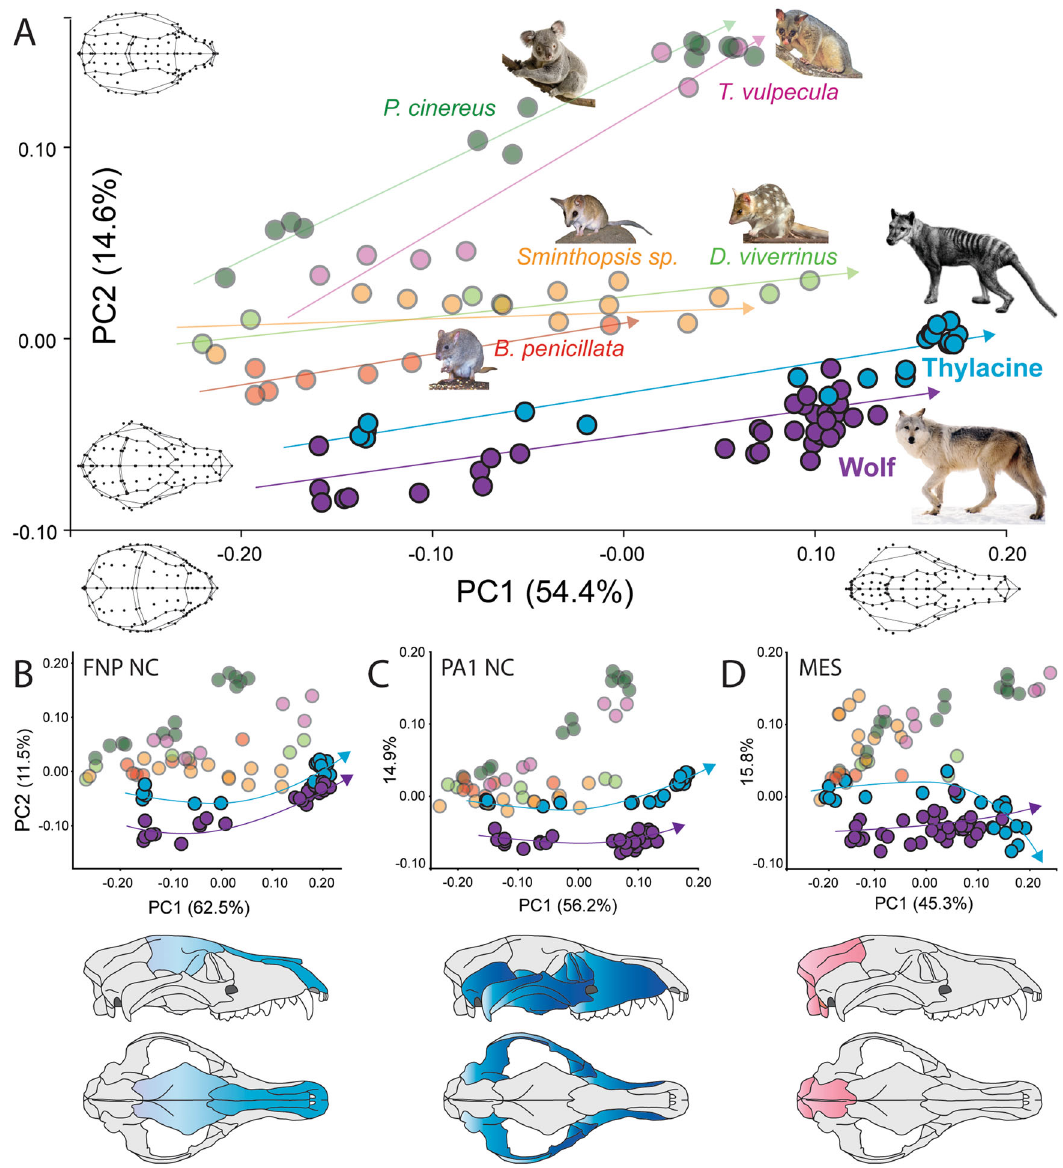
Fig. 2 Ontogenetic cranial variation and mosaic evolution. A Principal component analysis of ontogenetic cranial shape for each species included in the study. PC1 represents age-related shape change (left to right), whereas PC2 separates herbivorous and carnivorous taxa. The thylacine and wolf display parallel similarities throughout ontogeny, compared with other marsupials. B – D Subsampling of cranial shape into bone groups with shared embryonic tissue origins. The thylacine and wolf show shape overlap between bones of B FNP and D MES origin, but not in bones of C PA origin. Animal images were used under CC BY 4.0 open